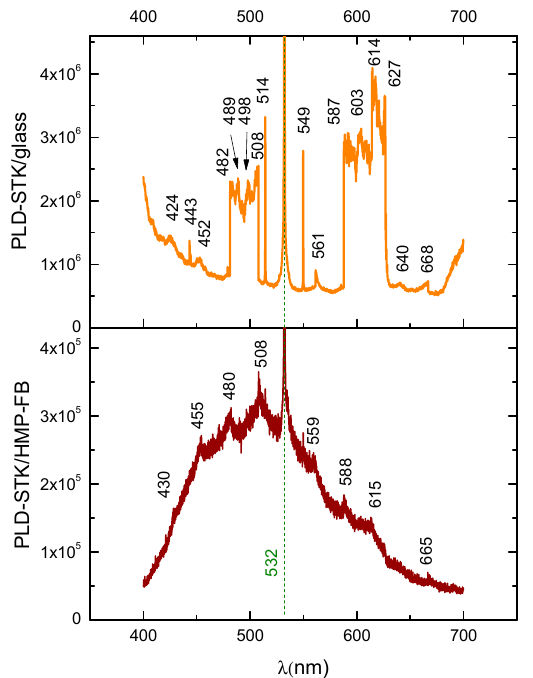
Figure 8. Experimental device.